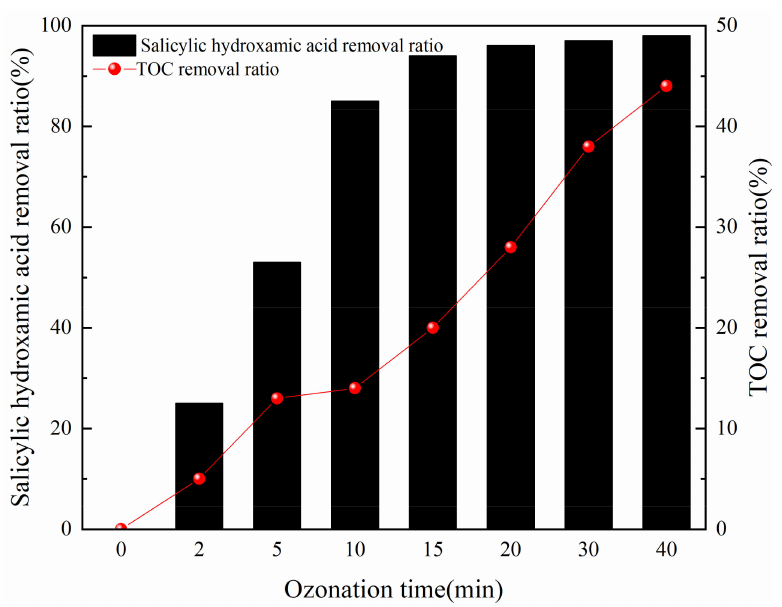
Figure 10. Treatment efficiency of salicylic hydroxamic acid and TOC under the optimal conditions.